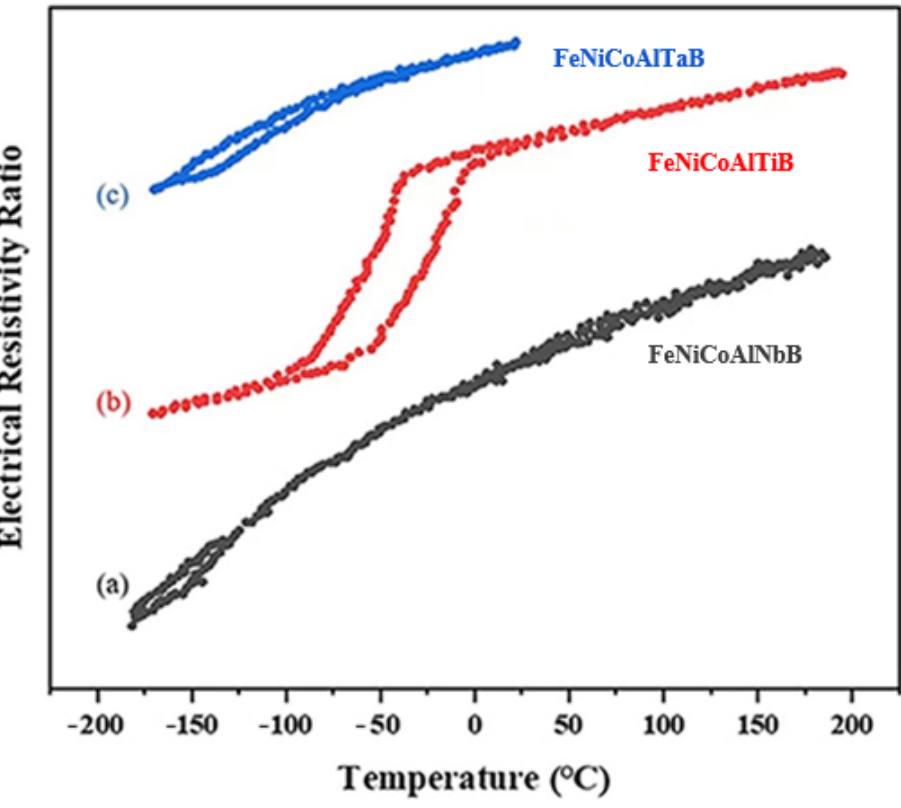
Figure 16. Resistivity curves: ( a ) FeNiCoAlNbB; ( b ) FeNiCoAlTiB; ( c ) FeNiCoAlTaB.